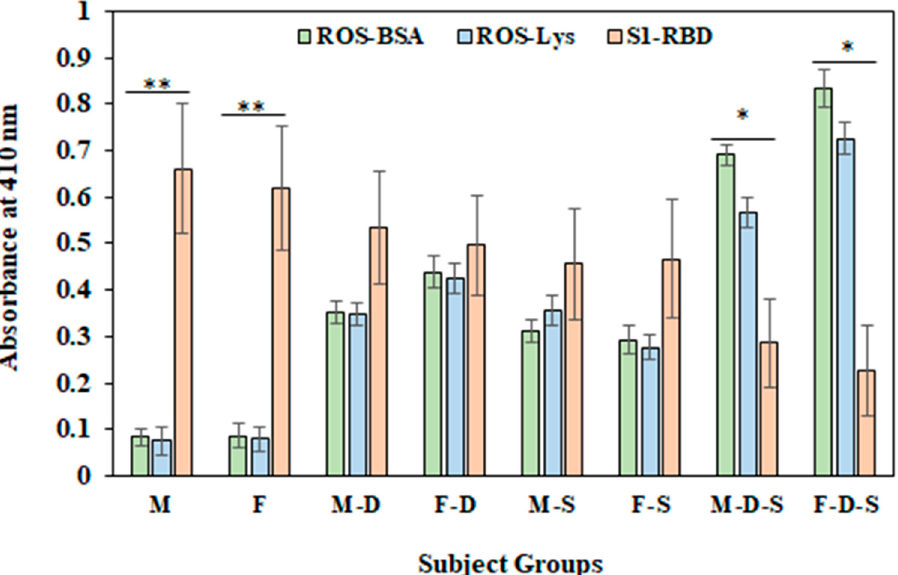
Figure 7. Detection of serum autoantibodies against ROS modified proteins (BSA and Lys) and S1-RBD antigen using direct binding ELISA. ELISA plates were coated with 5 µg/mL antigens. Each group consisted of 15 subjects. Values are given as mean ± SD. The t test was adopted for the comparison between the two groups, and significance is defined as * p < 0.05, ** p < 0.01. In groups M (0.661 ± 0.121) and F (0.618 ± 0.133), significantly high levels of the S1-